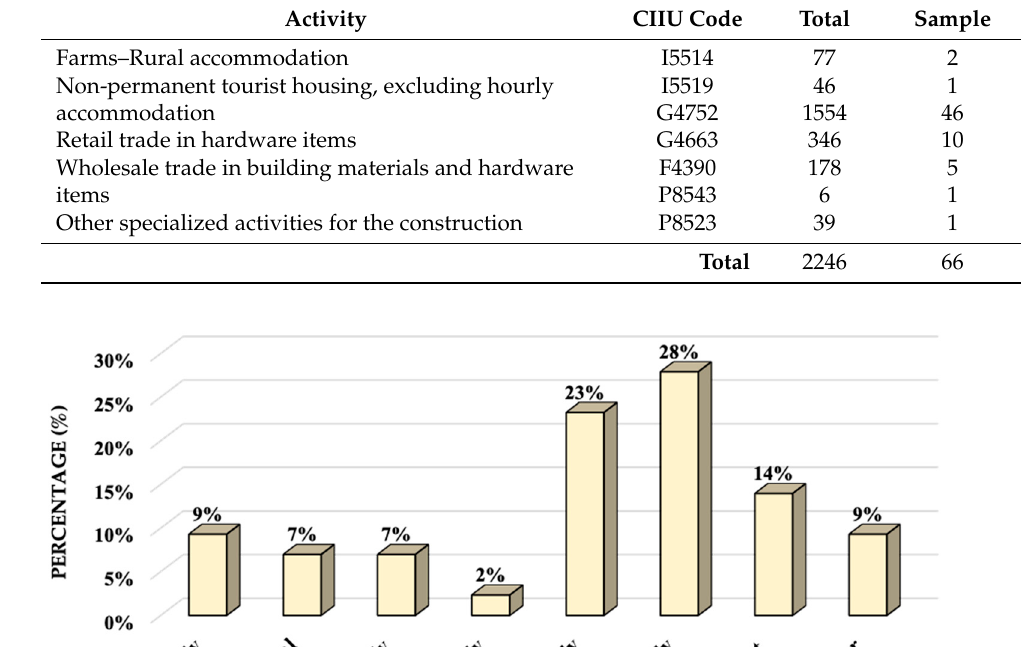
Table 3. Target population and sample size calculated for the market study of the start-up of a nonconventional plastic sand cobbles plant in the city of Ibague—Colombia.